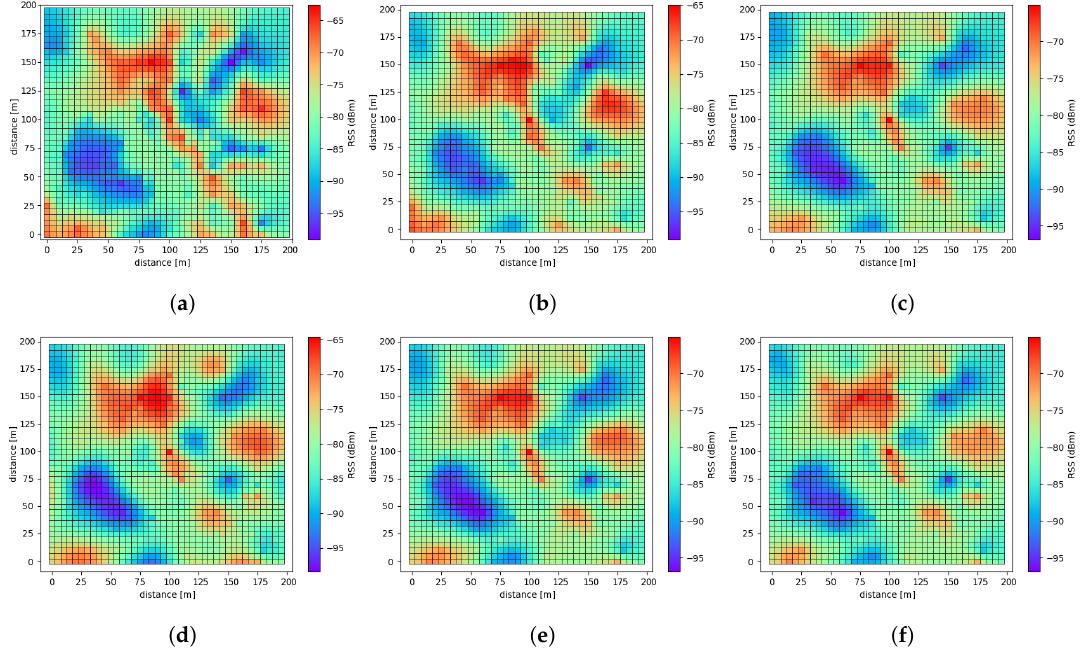
Figure 13. ( a ) Original REM constructed by OESD. ( b ) REM based on the proposed SVM regression model. ( c ) REM based on the linear model. ( d ) REM based on the Gaussian model. ( e ) REM based on the spherical model. ( f ) REM based on the exponential